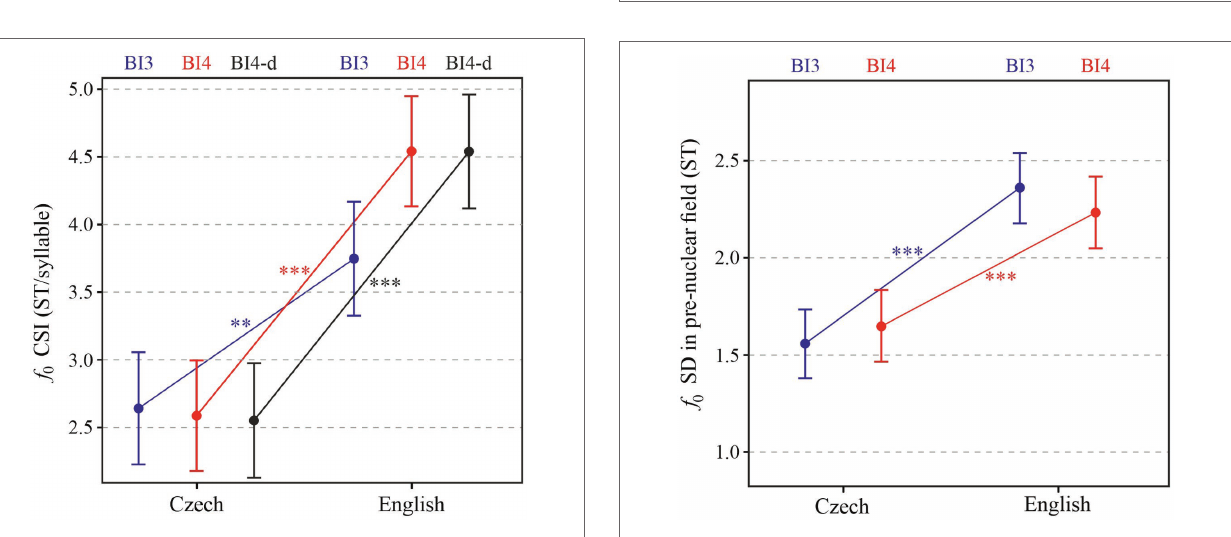
FIGURE 8 | Standard deviation of f 0 in the pre-nuclear field of each prosodic phrase depending on L anguage and P rosodic break type (BI3 in blue, BI4 in red, and BI4-d in black). *** p <